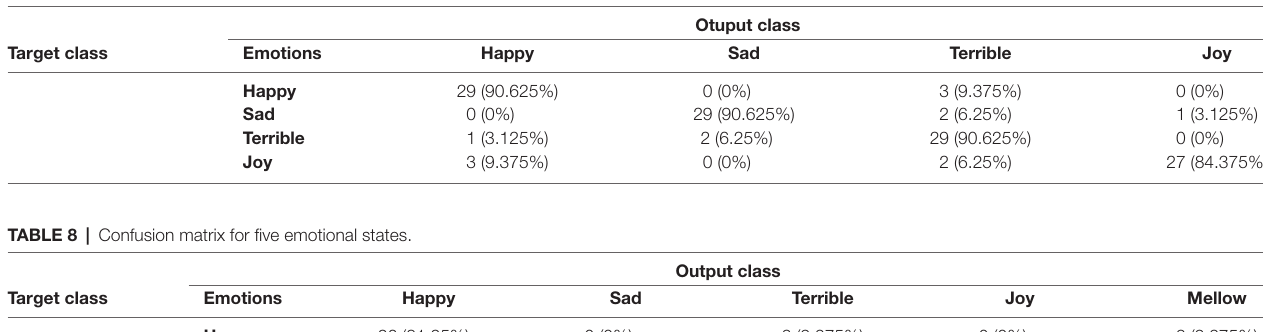
TABLE 7 | Confusion matrix for four emotional states.